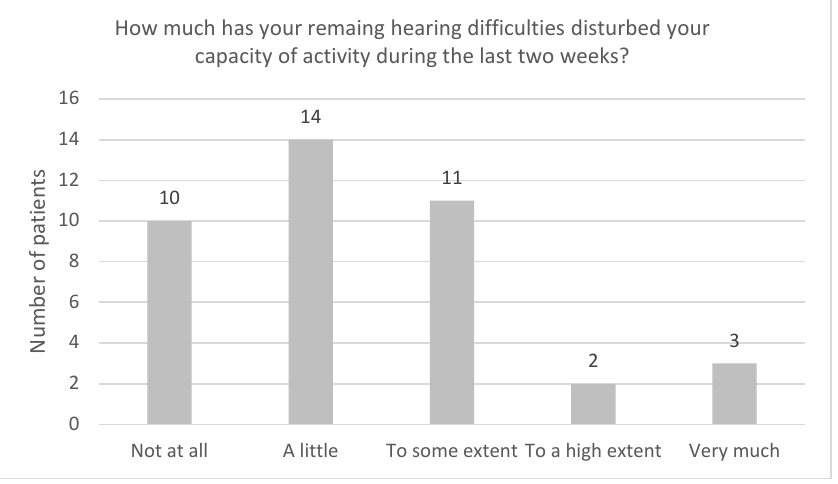
Figure 10. How much have your remaining hearing difficulties disturbed your activity capacity during the last two weeks?